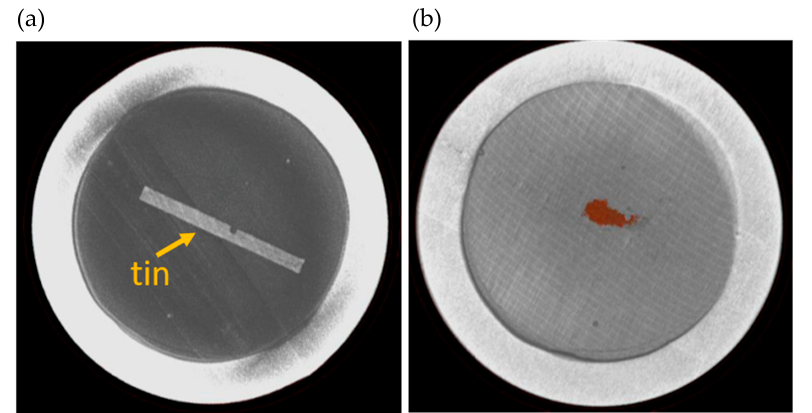
Figure 7. Cross section of a post furnace X-ray micro-computed tomography (XCT) image with zinc (blue), tin (maroon), superimposed over pre-furnaced image of a container sealed in air. Melt wires without color were taken before the furnace test. Melt wires with color were taken after exceeding the melting point of all three materials indicating no visible changes on two out of three wires when encapsulated in air.